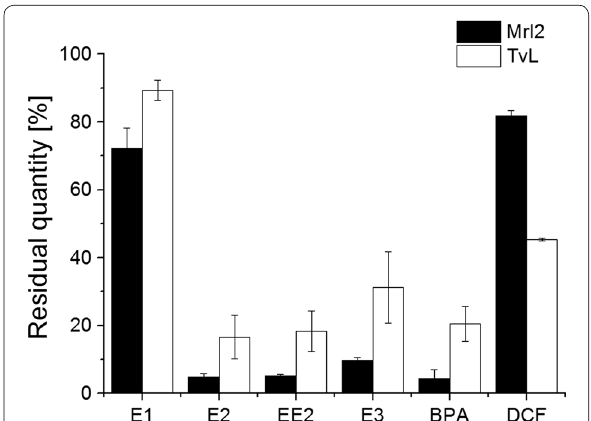
Fig. 4 Residual quantity of EDCs and NSAIDs (%) after 0.5, 1 and 20 h of incubation with 20 U ml − 1 Mrl2 at room temperature in 50 mM potassium phosphate buffer, pH 7. Measurements were carried out in triplicate